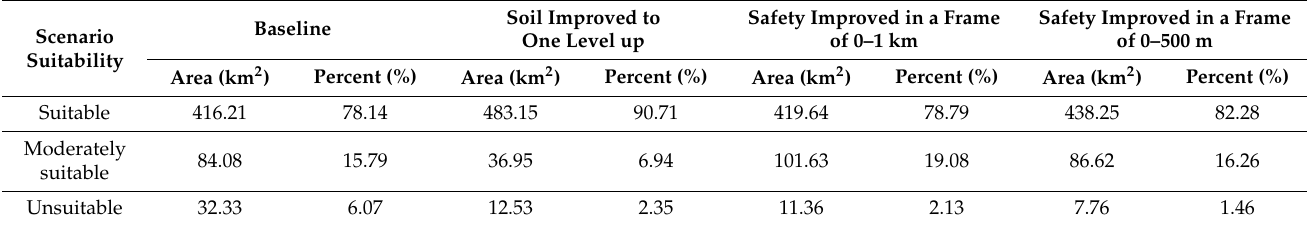
Table 7. Urban agriculture